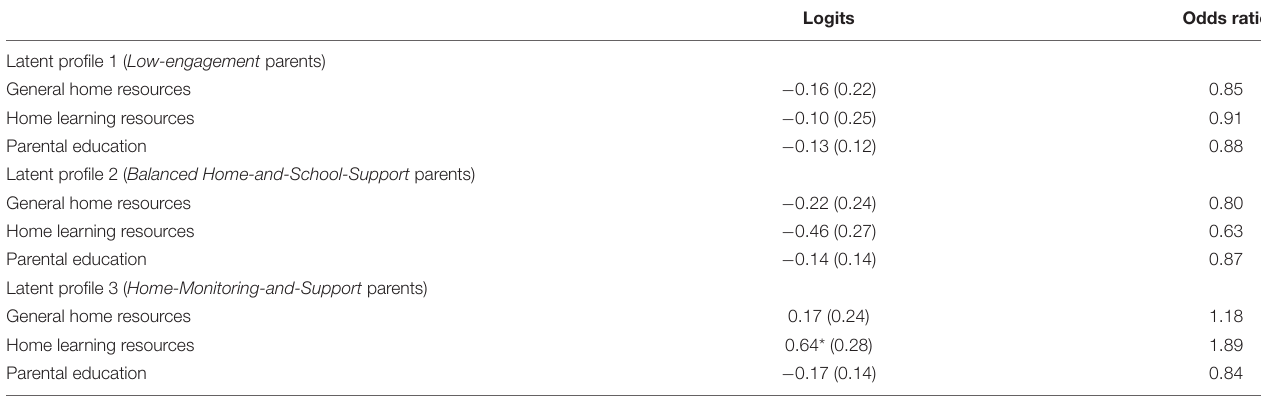
TABLE 12 | SES and latent profile membership (secondary